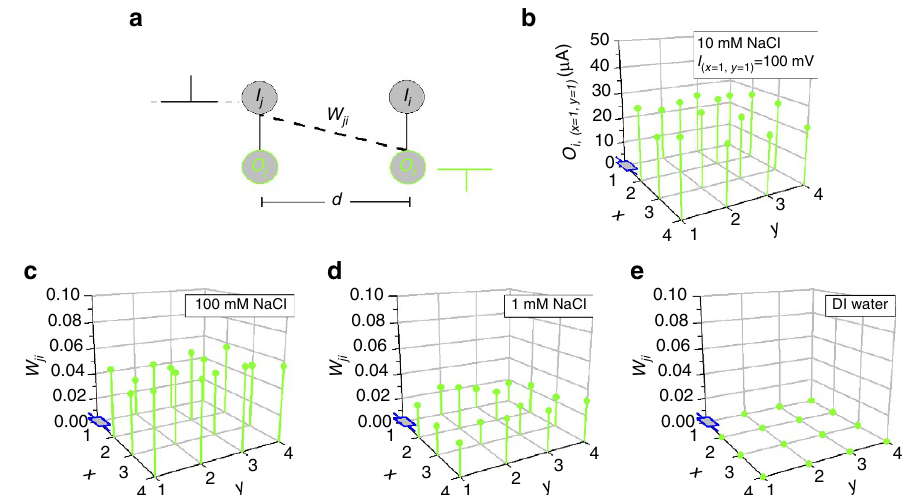
Figure 4 | Lateral communication of devices through soft electrolyte connections. ( a ) Schematic of lateral communication and definition of the soft connection weight w ji . ( b ) Spatial map of the output O i, ( x ¼ 1, y ¼ 1) of the device at coordinates (1, 1) when a pulse is applied at local input I j (x a 1 , y a 1) (amplitude of 100mV, width of 50ms) of devices at coordinates x a 1, y a 1. The distance d between the devices is 5mm. ( c – e ) Spatial mapping of the connection weight w ji (defined as O i / O MAX, i ) for different electrolyte concentrations (100mM, 1mM, DI water).